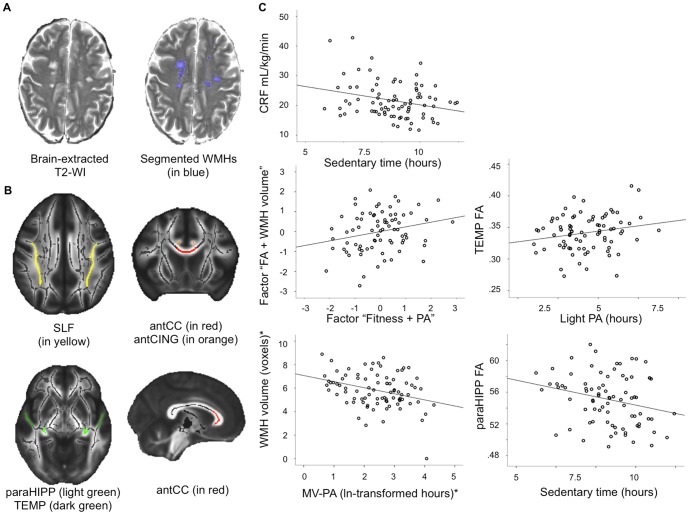
Illustration of WMH volume and FA analyses.A: An example of segmentation of WMHs on a T2-weighted image. B: Regions of interest for DTI analysis. Mean WM skeleton overlaid on FMRIB58_FA mean FA image. Anterior corpus callosum (antCC), anterior cingulum (antCING), superior longitudinal fasciculus (SLF), temporal lobe WM (TEMP), and parahippocampal WM (paraHIPP). C: Scatterplots showing the representative relationships between PA, CRF, and WM integrity. *Indicates that the variable was ln-transformed.